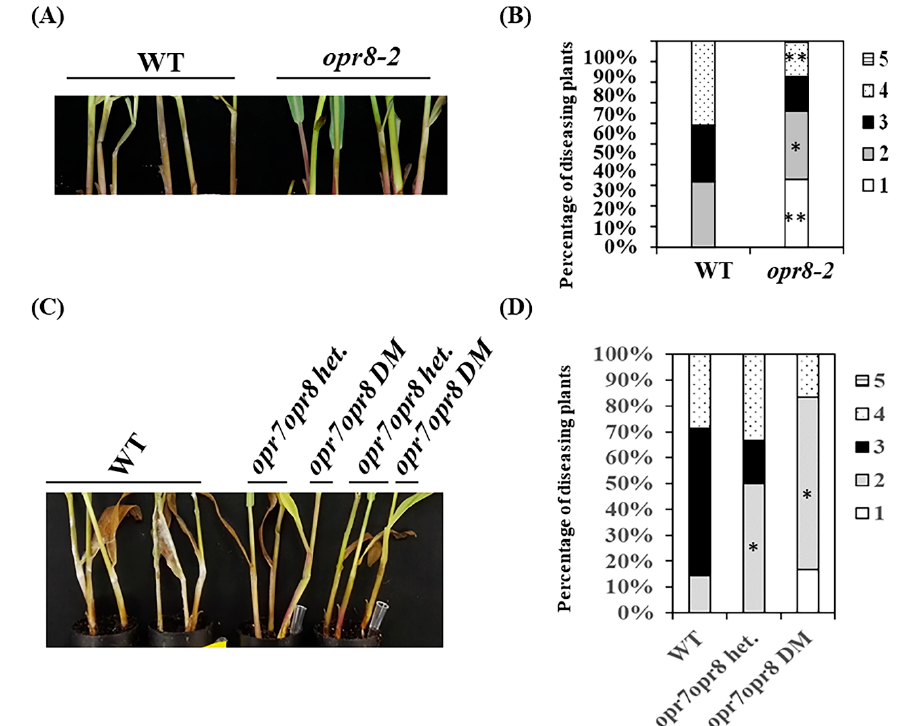
Figure 6. opr7opr8 mutants are more resistant to F. graminearum . ( A ) a representative picture shows the disease symptoms of opr8-2 mutant vs. WT at 3 dpi; ( B ) the disease levels of WT and opr8-2 mutants recorded at 3 dpi; ( C ) a representative picture shows the disease symptoms of opr7-5opr8-2 DM, opr7-5opr8-2 heterozygous and WT at 4 dpi; ( D ) the disease levels of WT, opr7-5opr8-2 heterozygous and opr7-5opr8-2 DM recorded at 3 dpi. The percentage of diseased plants was calculated based on the number of plants at each level over total plants. The experiments were replicated three times with similar results and the representative data are shown. * and ** on the bars indicate significant differences between mutants and wild-type at p < 0.05 and p < 0.01 level, respectively, analyzed by the two-way ANOVA.